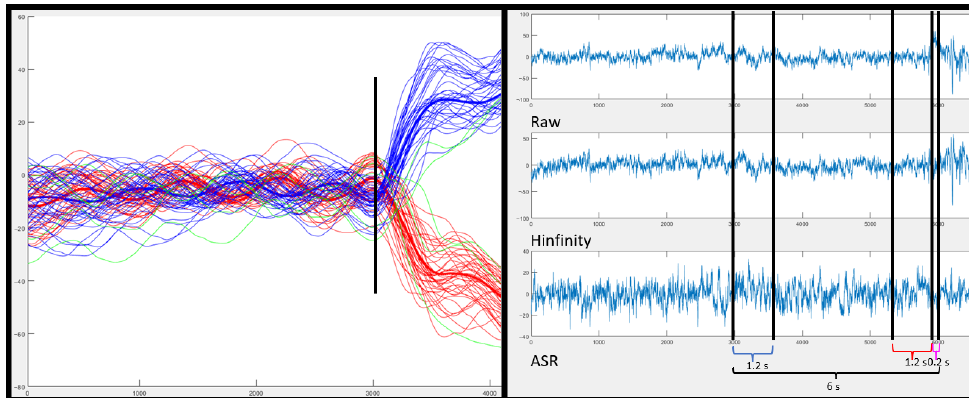
Figure 2. On the left : Image of the processed IMU signal. In black, the moment classified as turn. In blue highlighted, the average number of turns on the left and in red highlighted, the average number of turns on the right. In green, the turns that did not meet the criteria assigned to the turn type (left or right) assigned by the algorithm. On the right : the EEG signal of the third turn for the Fz channel of subject S2. Labeled with respect to the turning point marked on the IMUs. For the segmented class in blue monotonous walk and for the intention turn class in red. According to the raw EEG signal (first image), the signal filtered with H ∞ (second image) and the signal filtered with ASR (third